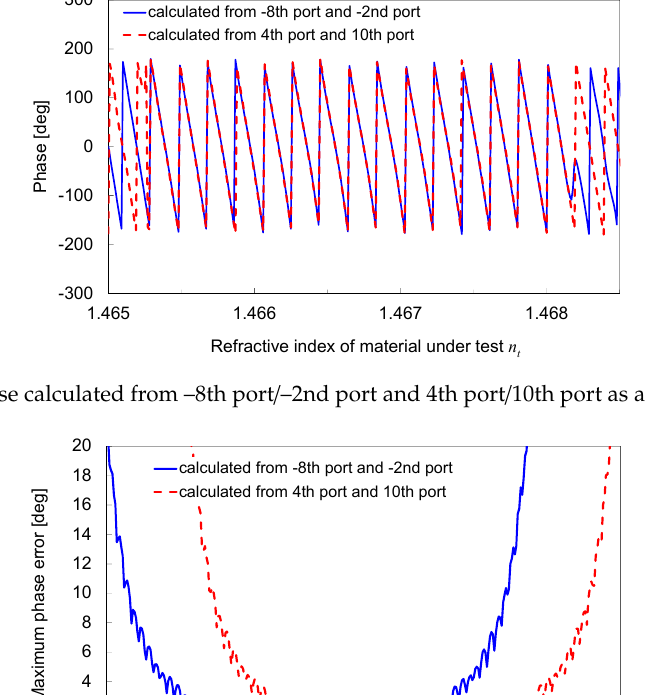
Figure 9. Deviation of phase calculated from –8th port/–2nd port and 4th port/10th port under condition that monitored output power is deviated by ±0.05 dB.